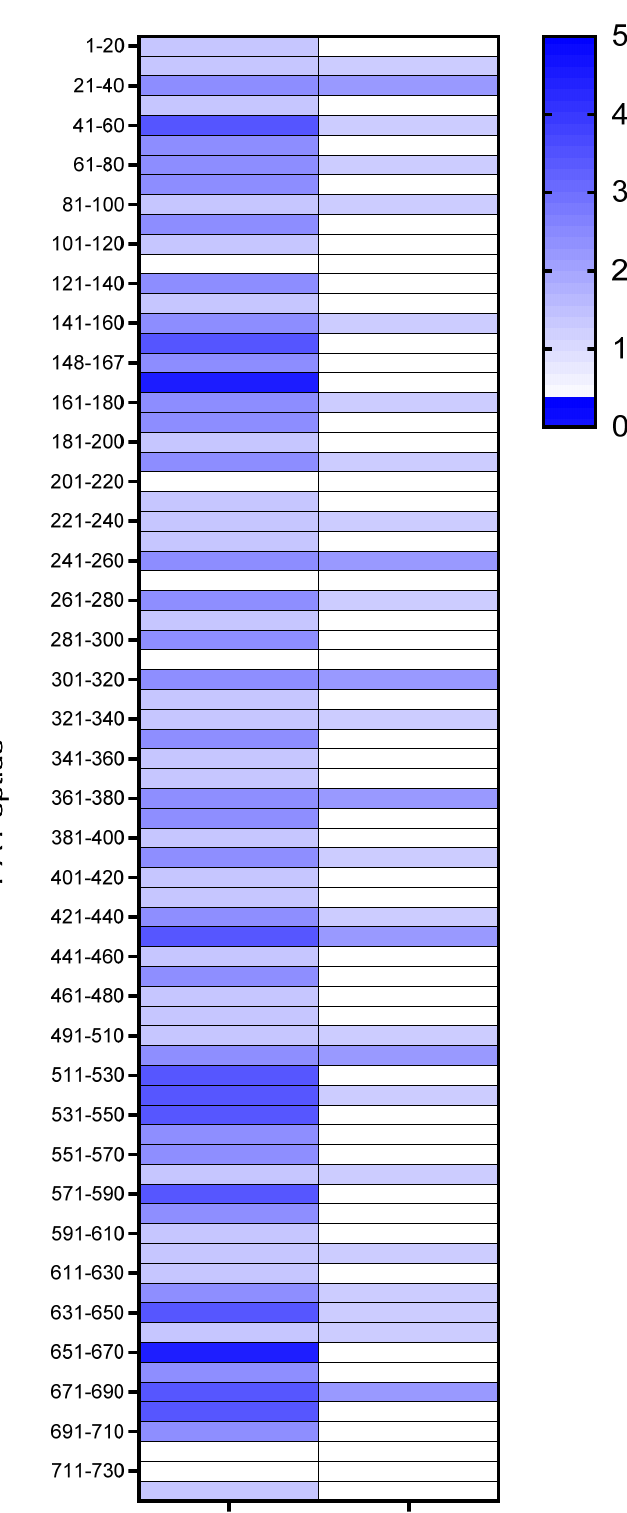
Figure 1. Heat map of CD4+ T cell epitope responses to anthrax PA domain I–IV peptides in human donors. Heat map representation of the epitope mapping results observed for positive CD4+ T cell IFN γ ELIspot responses in the human donor cohorts, comprising a total of 9 donors in the cutaneous anthrax (Kayseri) group and 10 donors in the AVP vaccinees (UK) group. Peptides were considered positive for the carriage of a CD4+ T cell epitope if the response was >50 SFC/106 PBMCs and